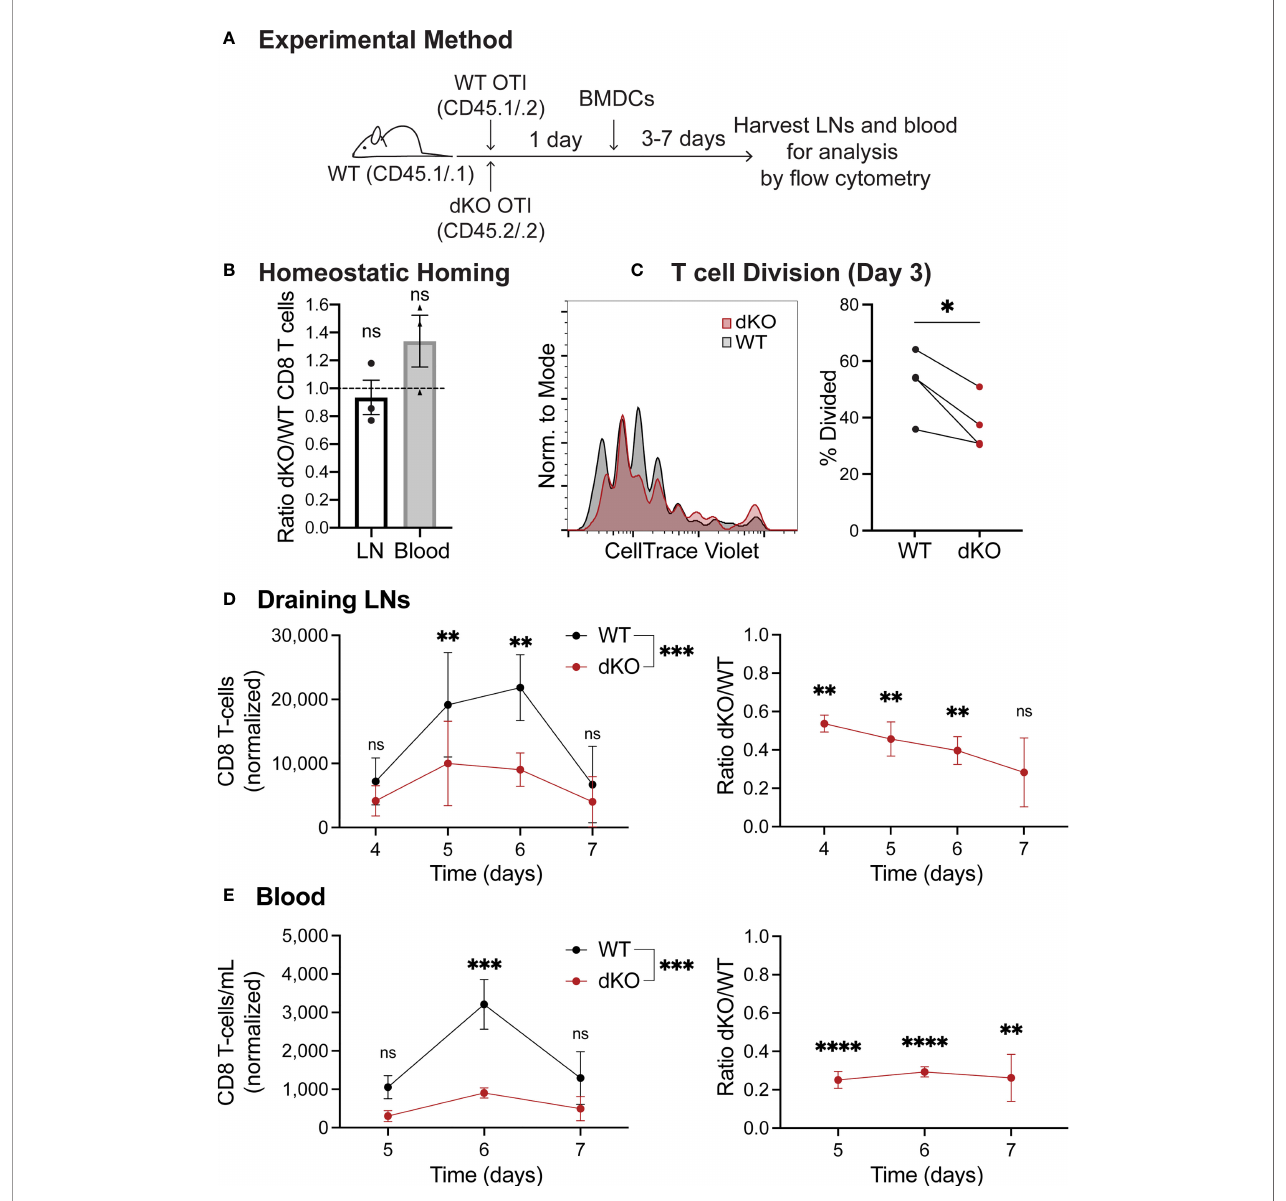
FIGURE 2 | Ena/VASP de fi ciency reduces T cell expansion in response to stimulation with bone marrow-derived dendritic cells in vivo . Congenically distinct naïve WT CD45 .1/.2 OT-I and EVL/VASP dKO CD45 .2/.2 OT-I T cells were isolated from donor mice and co-transferred I.V. into WT CD45 .1/.1 recipient mice. (A) Graphical schematic of the experimental method. (B) WT and EVL/VASP dKO T cells have similar homing to LNs and persistence in the blood. 1×10 6 WT and EVL/VASP dKO naïve OT-I CD8 + T cells, were co-transferred I.V. into unimmunized WT CD45 .1/.1 recipient mice and LNs and blood were harvested 24 hours later to determine a homing and persistence baseline. (C – E) EVL/VASP dKO T cells have reduced proliferation and expansion in response to BMDC stimulation. 10,000 of each naïve WT CD45 .1/.2 OT-I and EVL/VASP dKO CD45 .2/.2 OT-I T cells were co-transferred I.V. into WT CD45 .1/.1 recipient mice. 24 hours later, 2.5×10 5 mature, LPS-activated OVA-pulsed BMDCs were injected subcutaneously into both hind footpads of recipient mice. At the indicated time-points, mice were euthanized and the draining popliteal LNs and blood were collected for analysis by fl ow cytometry. (C) Reduced proliferation of EVL/VASP dKO T cells. Example CTV proliferation dye dilution curves and quanti fi cation of the average percent of T cells divided, 3 days post BMDC immunization. (D, E) Reduced expansion of EVL/VASP dKO T cells. T cell numbers in draining popliteal LNs and blood measured at days 4 – 7 after stimulation with BMDCs (left) and ratios of EVL/VASP dKO/WT T cells (right). EVL/VASP dKO T cell numbers were normalized to the ratio of EVL/VASP dKO/WT T cells recovered from the equivalent tissue of unimmunized recipient mice from the same experiment. Data shown are means ± SEM from ≥ 3 experiments with ≥ 2 mice per group. Signi fi cance was assessed by 2-way ANOVA (for T cell numbers) and one sample t test compared to a hypothetical value of 1.0 (for the EVL/VASP dKO/WT ratio); ns is not signi fi cant, * is p < 0.05, ** is p < 0.01, *** is p < 0.001, and **** is p <